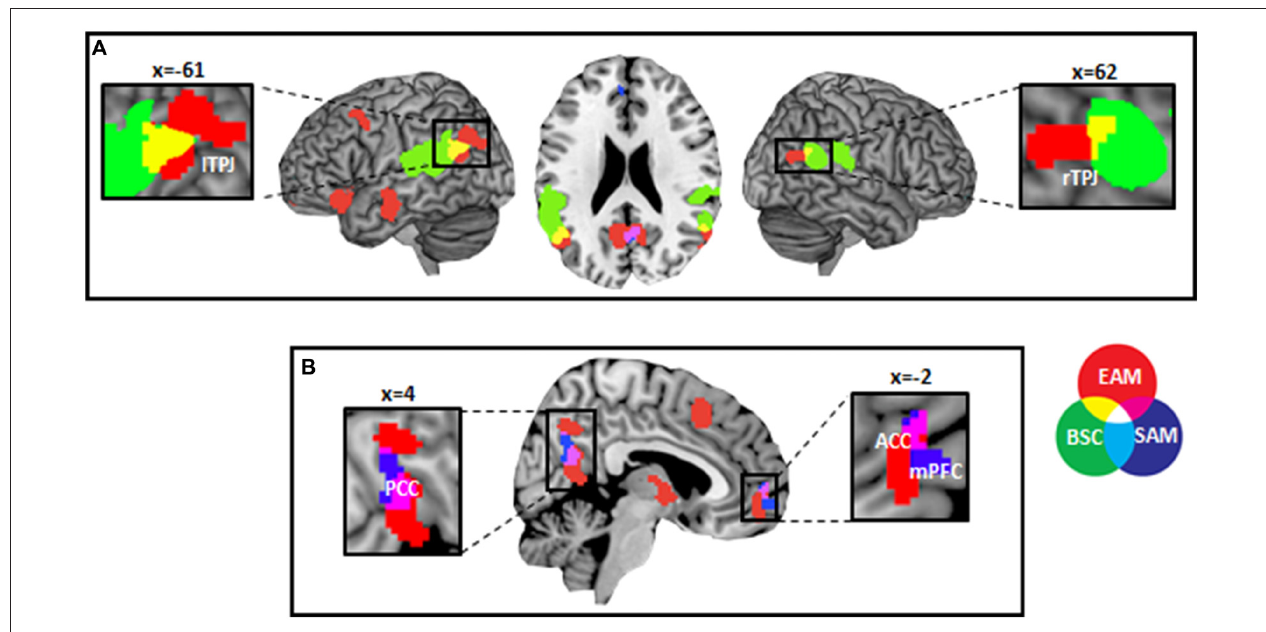
FIGURE 1 | Results of overlap analysis. (A) Visualization of the anatomical overlap between bodily self-consciousness (BSC; Ionta et al., 2011) and episodic autobiographical memory (EAM) activation likelihood estimation (ALE) analysis in bilateral parietal cortex. (B) Visualization of the anatomical overlap between semantic autobiographical memory (SAM) and EAM ALE analyses in the cortical midline structures. Within-cluster FWE-corrected p < 0.05 with p < 0.001 (uncorrected) as the cluster forming threshold. Label provided using the MRIcron.